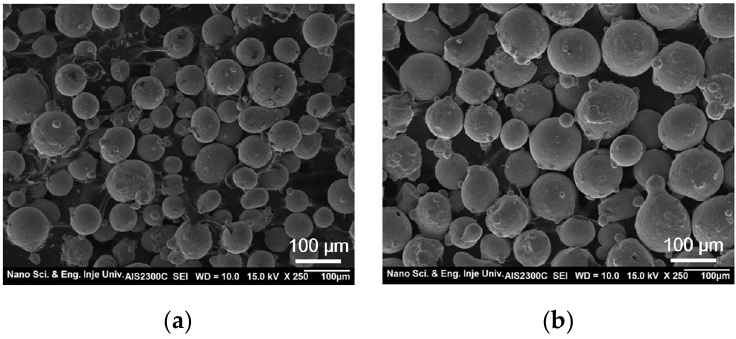
Figure 1. Spherical Powders used for 3D Printing deposition: ( a ) P21; ( b ) STS316L. Table 1. Chemical compositions (wt%) of the DED 3D printing powders used.